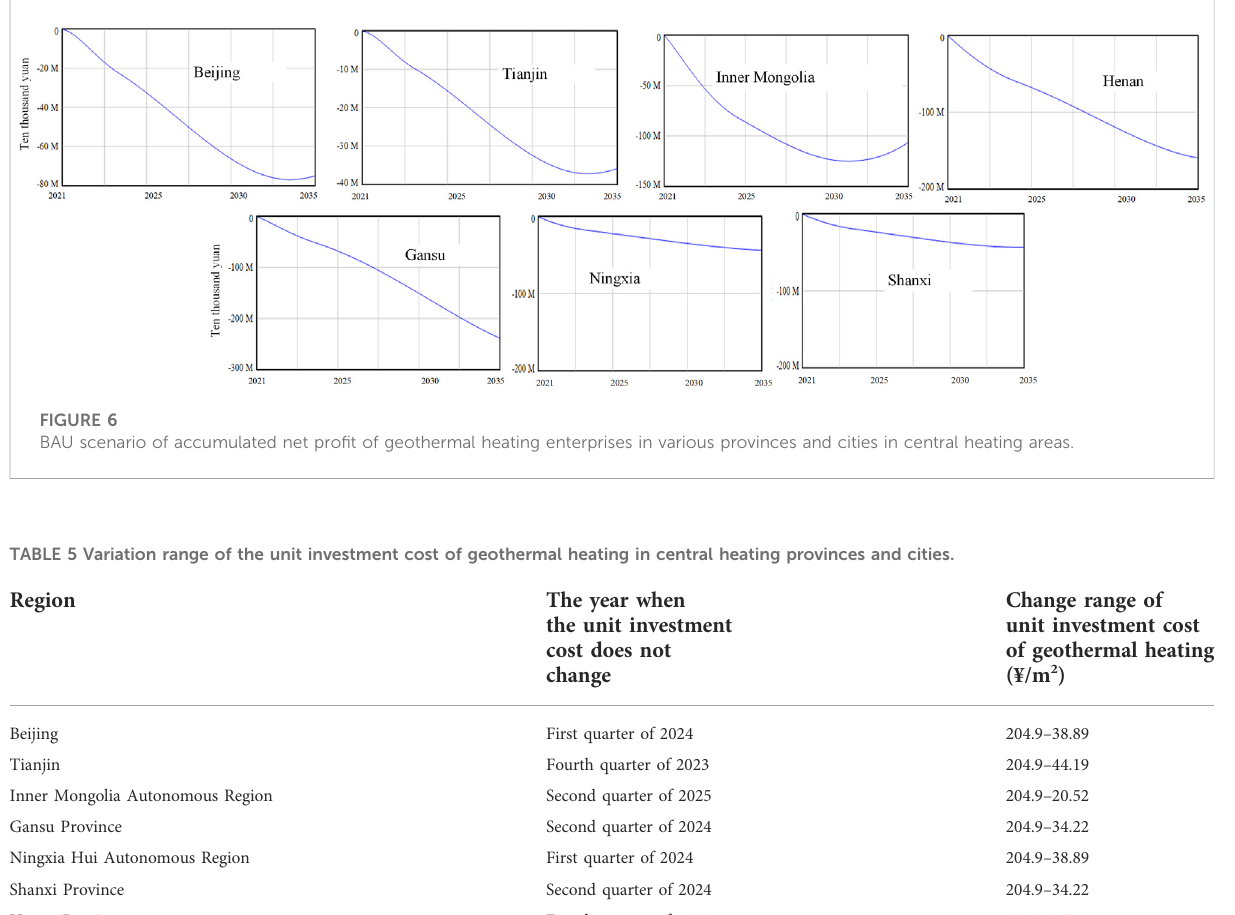
and price are adjusted, and the pro fi t and loss balance points of the three provinces and cities are calculated.